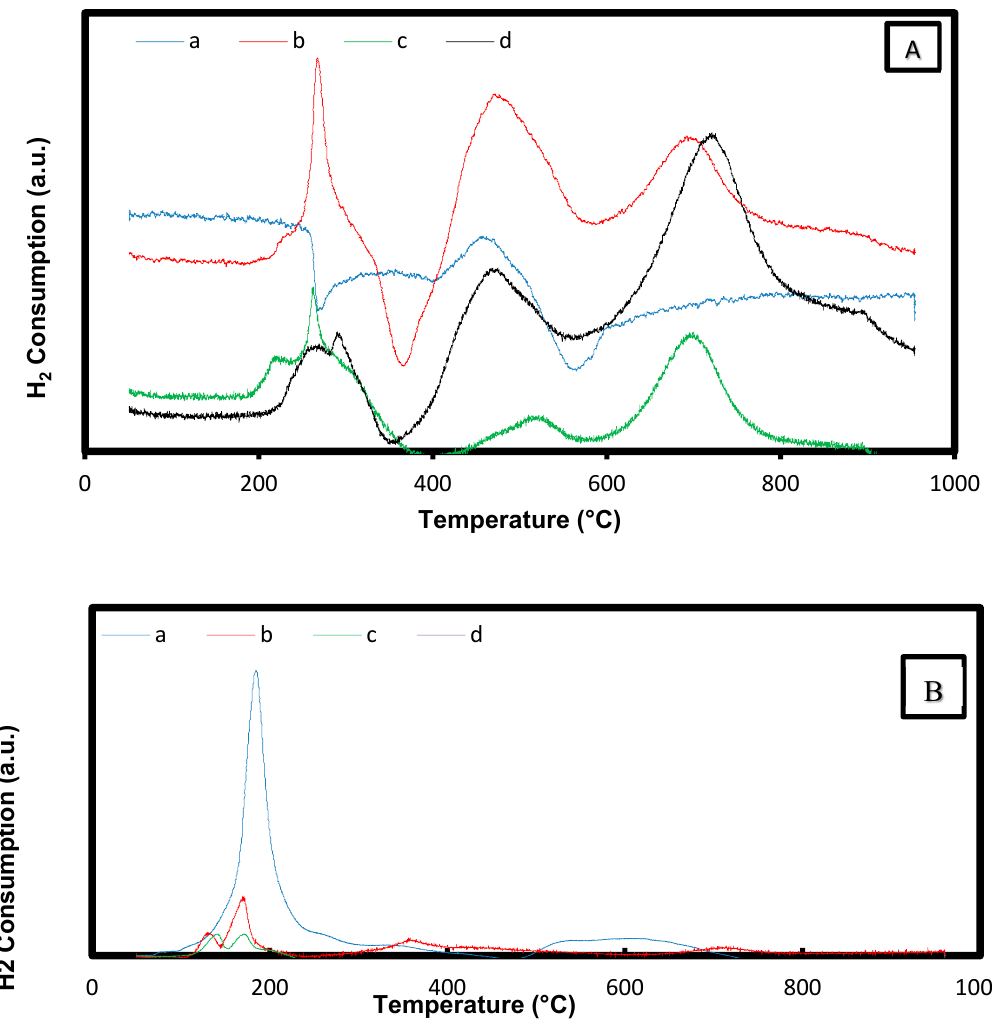
Figure 6. H 2 -TPR profiles of ( A ) Ni / Mg 1 − x Ce 4 + x O and ( B ) Ni,Pd,Pt / Mg 1 − x Ce 4 + x O catalysts, were (x = a (0.00), b (0.03), c (0.07), and d (0.15)) (reduced in a 5% H 2 /Ar stream at a 10 °C/min temperature ramp).